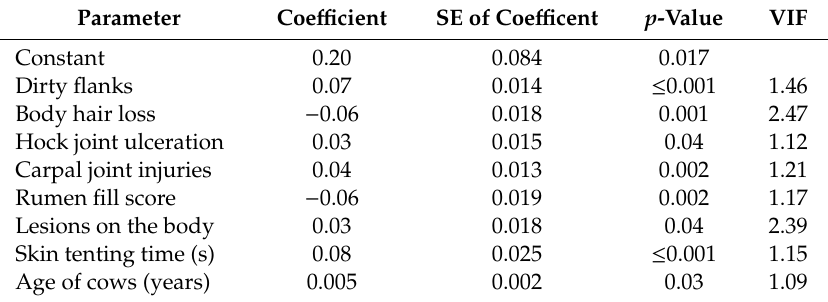
Table 6. Regression analysis of animal-based parameters significantly related ( p < 0.05) to hair cortisol concentration in log 10 pg / mg.